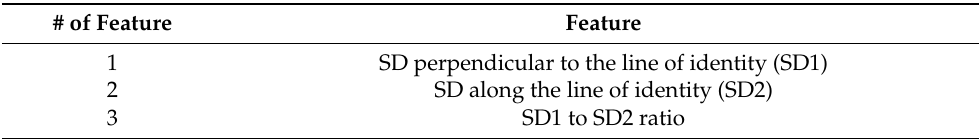
Table 10. Significant features from non-linear methods.